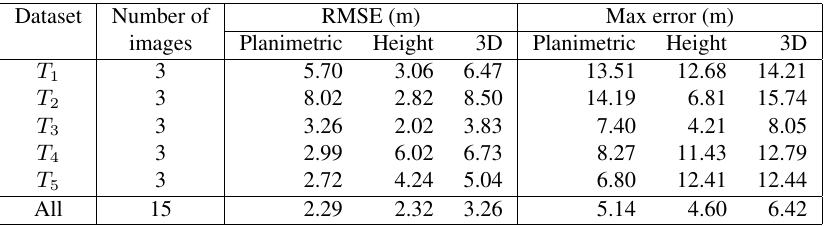
Table 1. Accuracy of object coordinates estimated by using the standard RPC model without bias correction